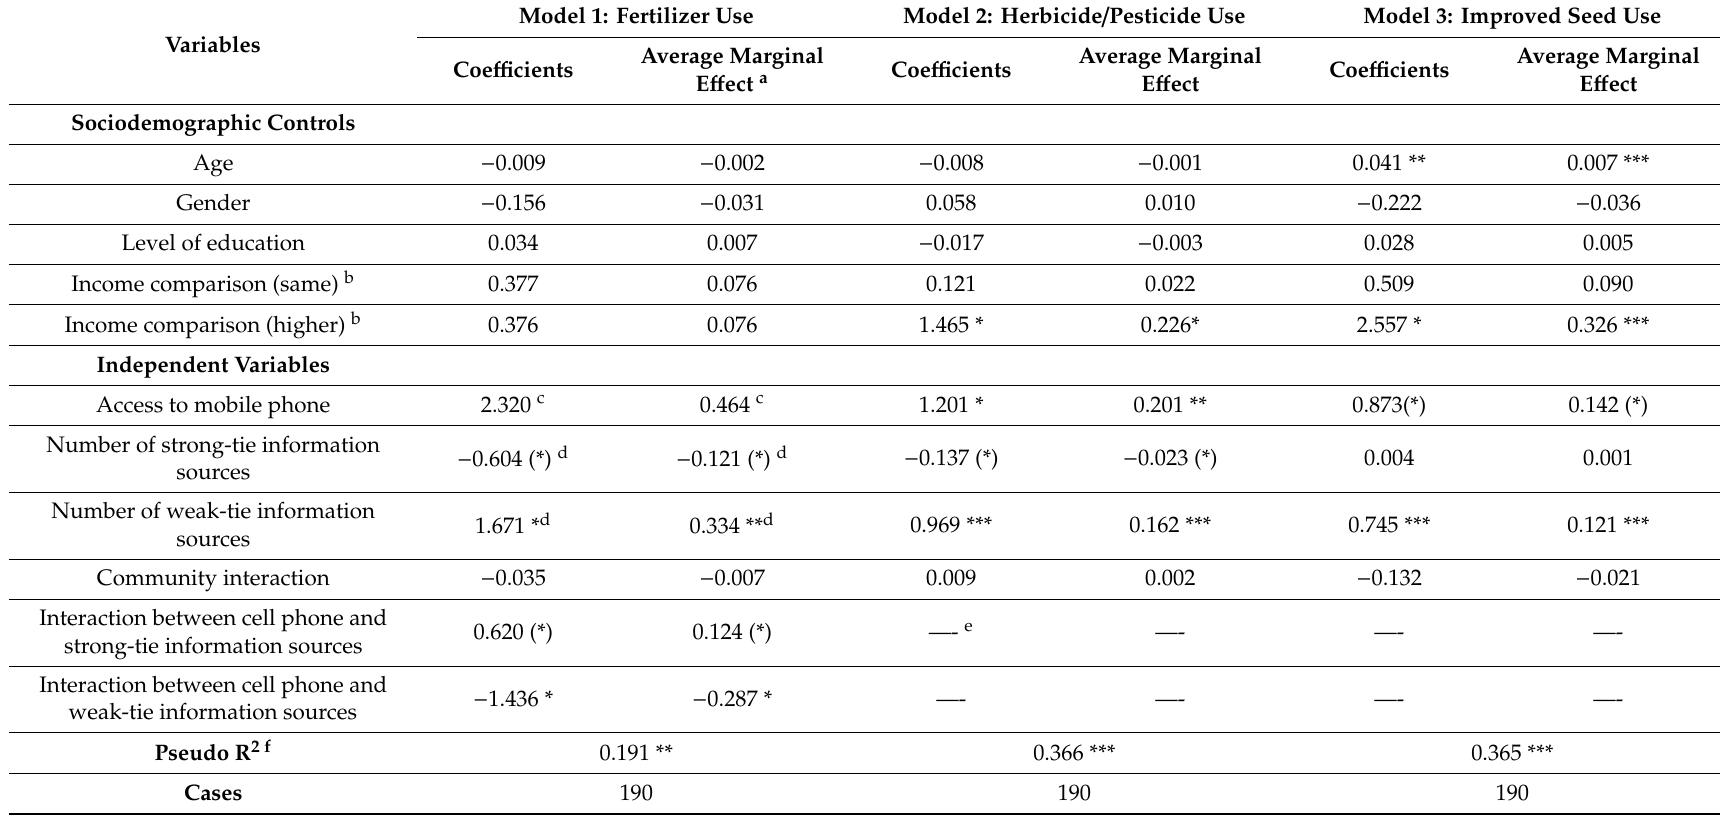
Table 2. Logistic regression models of di ff erent input